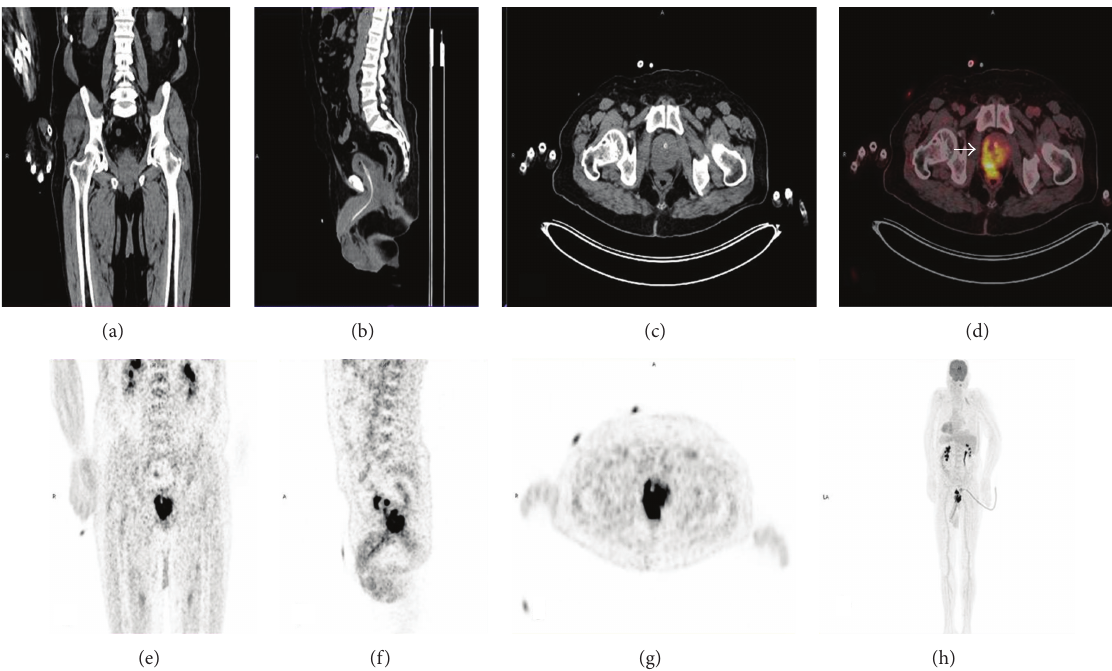
Figure 1: Coronal (a), sagittal (b), transaxial (c) CT, fused PET/CT (d) and coronal (e), sagittal (f), transaxial (g) PET, and MIP (h) images of the patient. Increased FDG uptake extending to the rectal wall was observed in the posterolateral part of the prostate gland ((d), arrow).